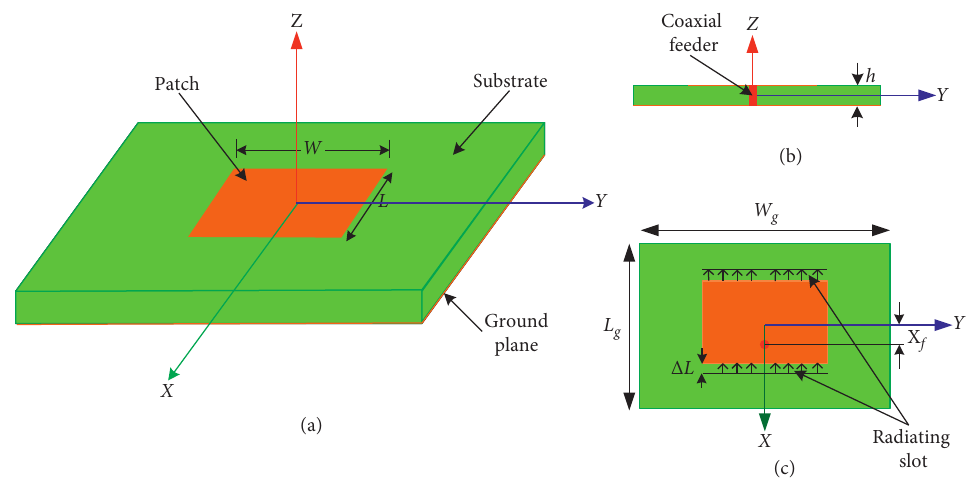
Figure 1: Geometric relationship of the microstrip antenna. The (a) three-dimensional diagram, (b) front view, and (c) top